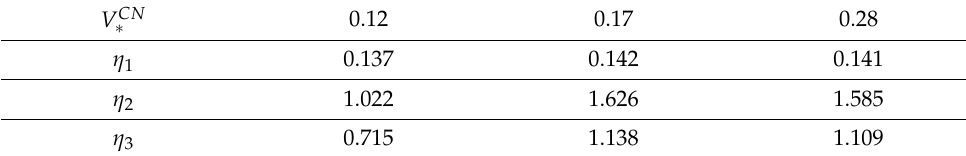
Table 3. The volume fractions of CNTs and corresponding efficiency